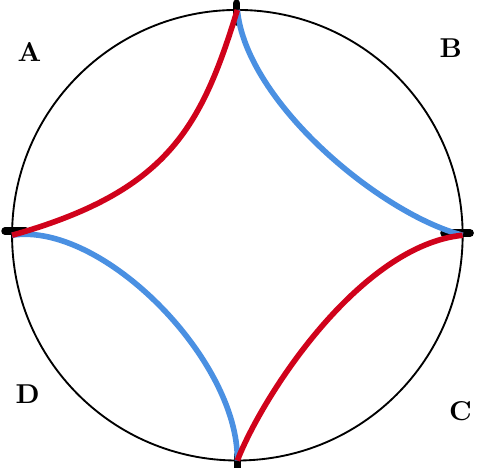
Figure 7 . Obtaining the RT surfaces of disconnected regions as unions of RT surfaces of connected regions. The red curve is the union of the RT surface of A (with length S ( A ) ) and the RT surface of C (with length S ( C ) ); the blue curve is the union of the RT surface of ABC ≡ D (with length S ( D ) ) and the RT surface of B (with length S ( B ) ). Both are extremal surfaces ending on AC ≡ A ∪ C ; we must therefore have S ( AC ) ≤ min ( S ( A ) + S ( C ) , S ( B ) + S ( D )) . For a single disconnected boundary, the validity of the RT formula implies that no further extremal surfaces exist, and the inequality is saturated. When the red curve is the RT surface, we say that the entanglement wedge of AC is disconnected; when the blue curve is the RT surface, we say it is